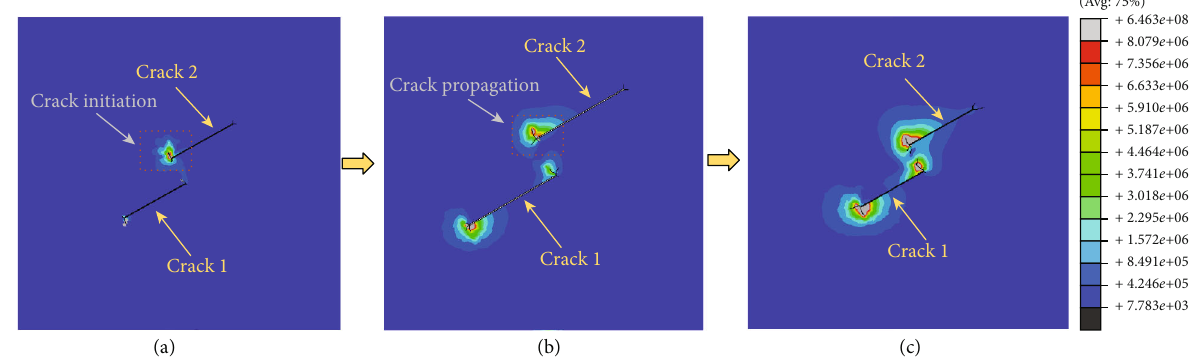
Figure 16: Model 13 stress distribution in numerical simulation. (a) t = 0 : 8 s . (b) t = 2 : 0s . (c) t = 3 : 5 s .